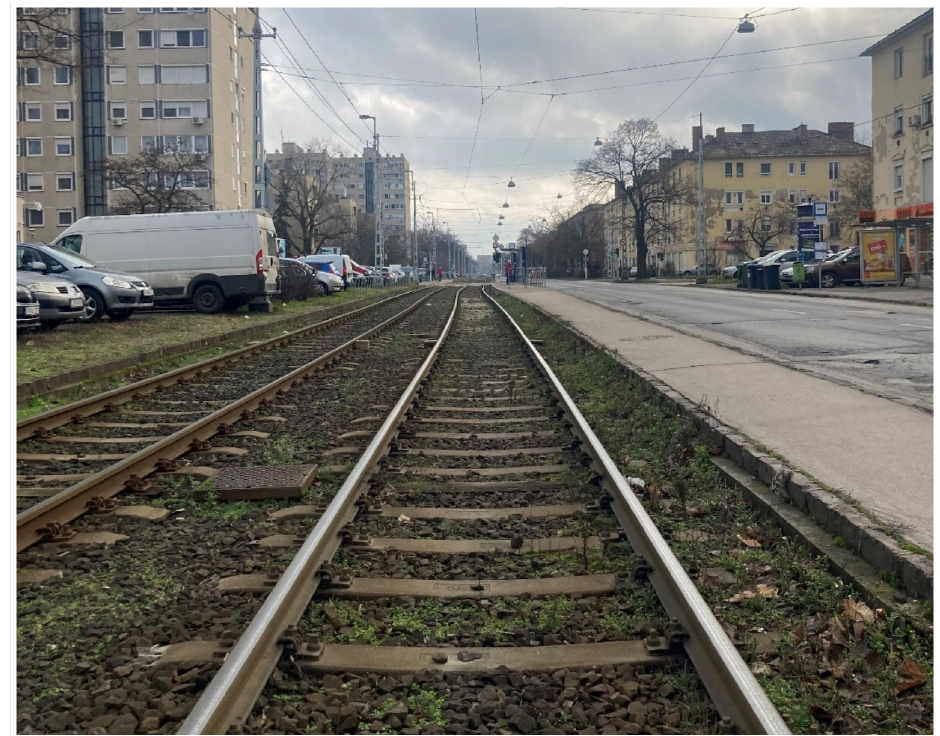
Figure 3. Photo of Section #3 (own